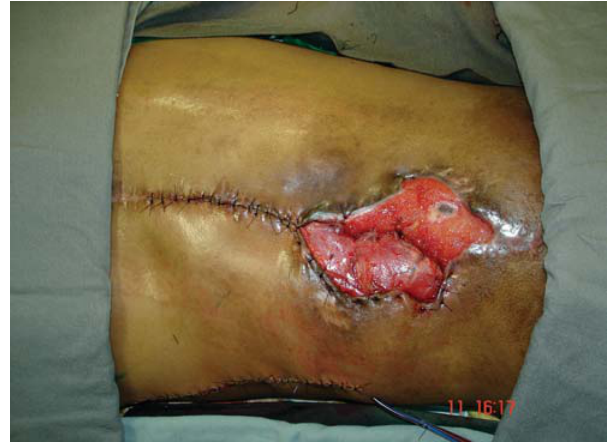
Figure 9 - The skin at the thoracic level was primarily closed over the trapezius flap